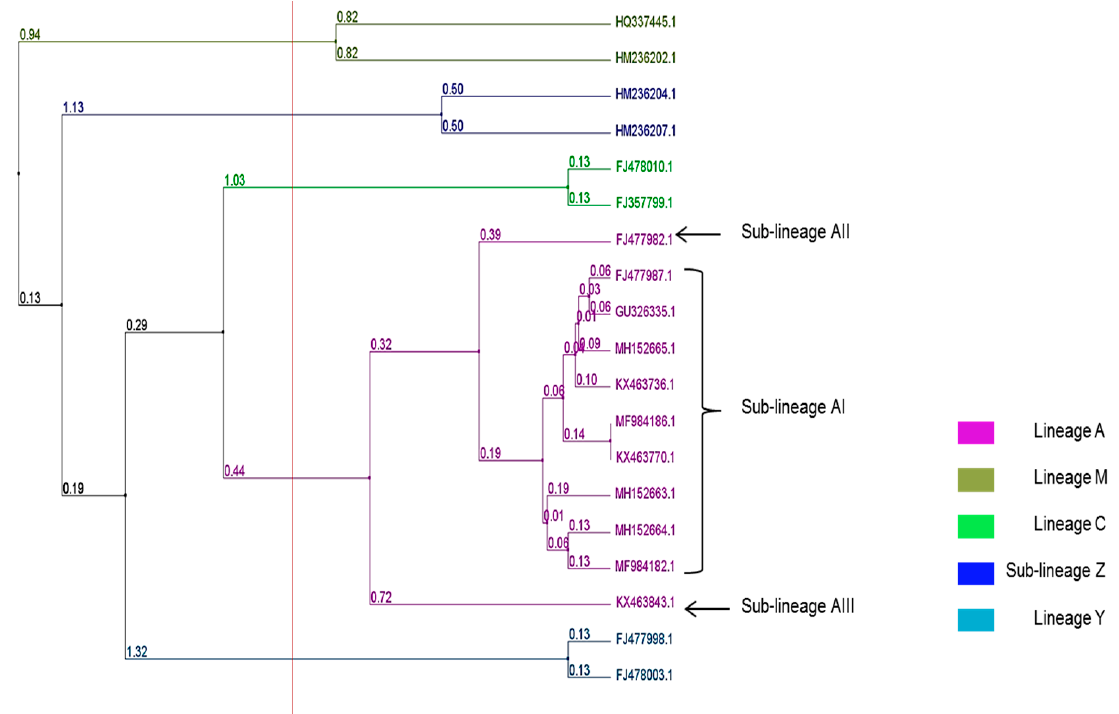
Figure 4. Phylogenetic tree of the mtDNA COI - COII sequence A 1s (MH152665), A 1q (MF984182), A 1r (MF984186), A 4o (MH152663), A 4r (MH152664), A 1 (KX463736), A 1e (GU326335) of honeybee populations in Côte d’Ivoire. Additionally, the observed mtDNA sequence recorded in the lineage Y (FJ478003 = Y 2d , FJ477998 = Y 1a ), M (HQ337445 = M 12 , HM236202 = M 63 ), C (FJ478010 = C 1 , FJ357799 =